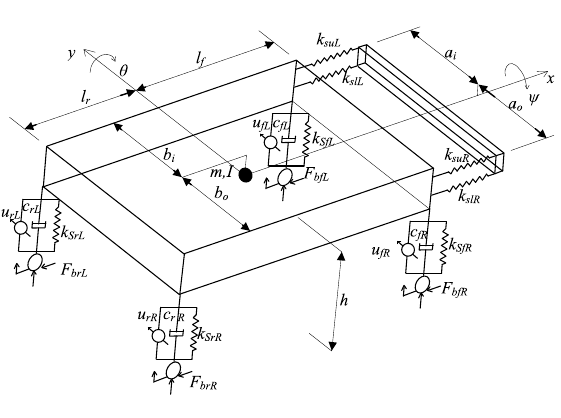
Figure 1. 6-DOF Vehicle Dynamics/Crash Mathematical Model.